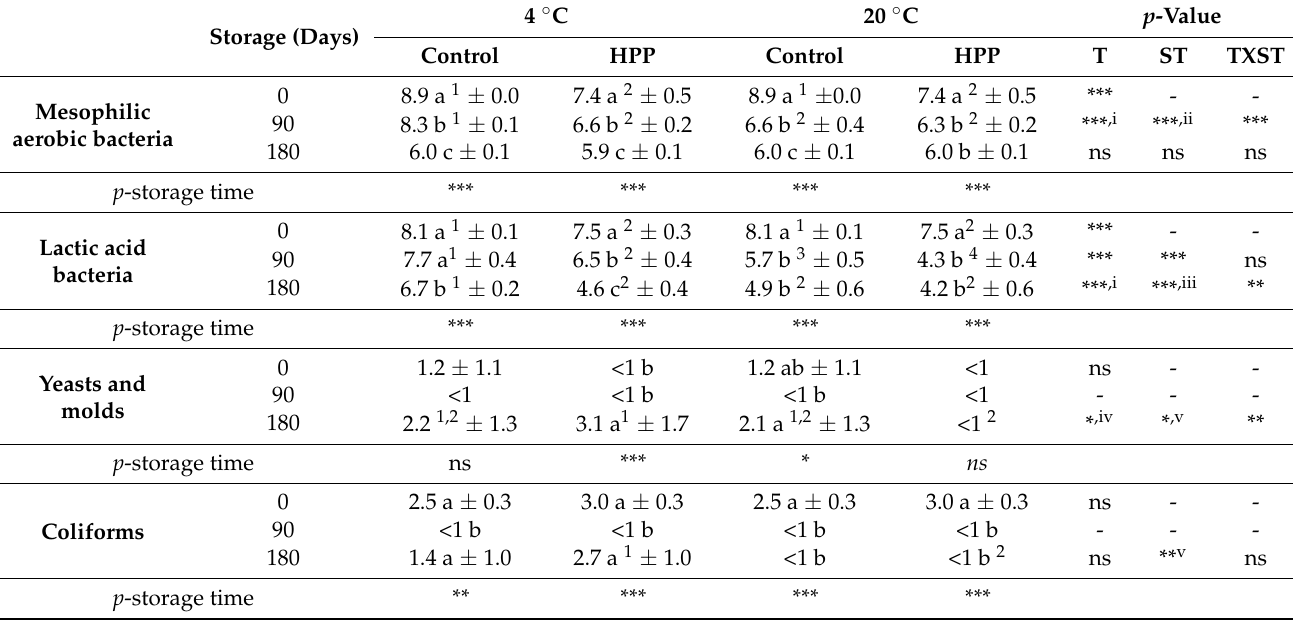
Table 2. Microbial counts (log CFU g − 1 ) (mean ± standard deviation) over the detection limit in sliced Iberian chorizo HPP (HPP) or not (Control), not stored (0) or stored at 4 or 20 ◦ C for 90 or 180 days, and significance from a one-way (storage time) ANOVA, a one-way (T, HPP) ANOVA